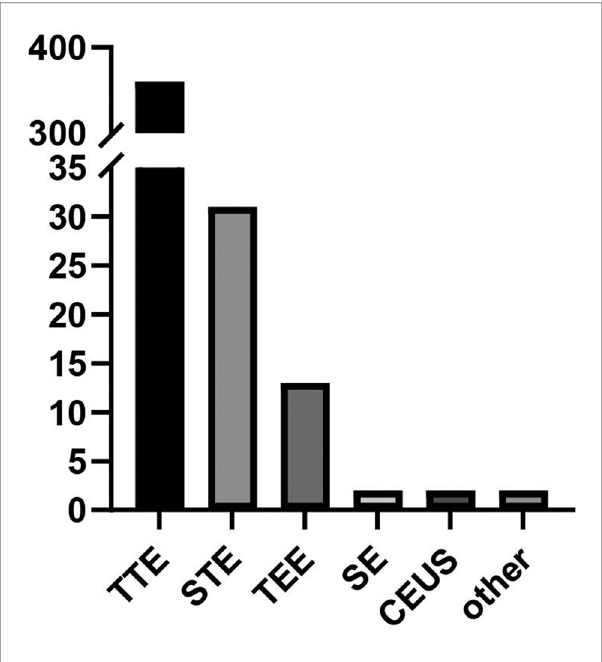
FIGURE 2 Clinical trial distribution with subclassi fi cations by different echocardiography